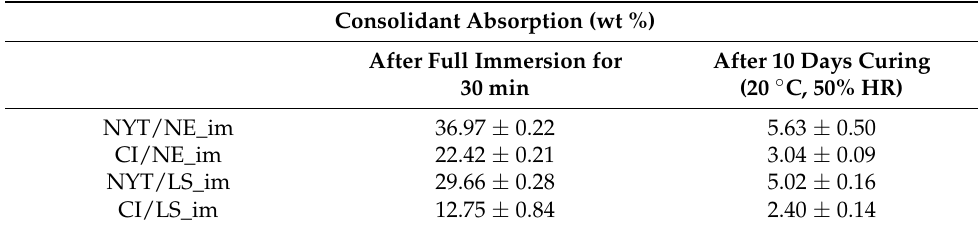
Table 3. NE and LS consolidant absorption after full immersion treatments (average values ± standard deviation).